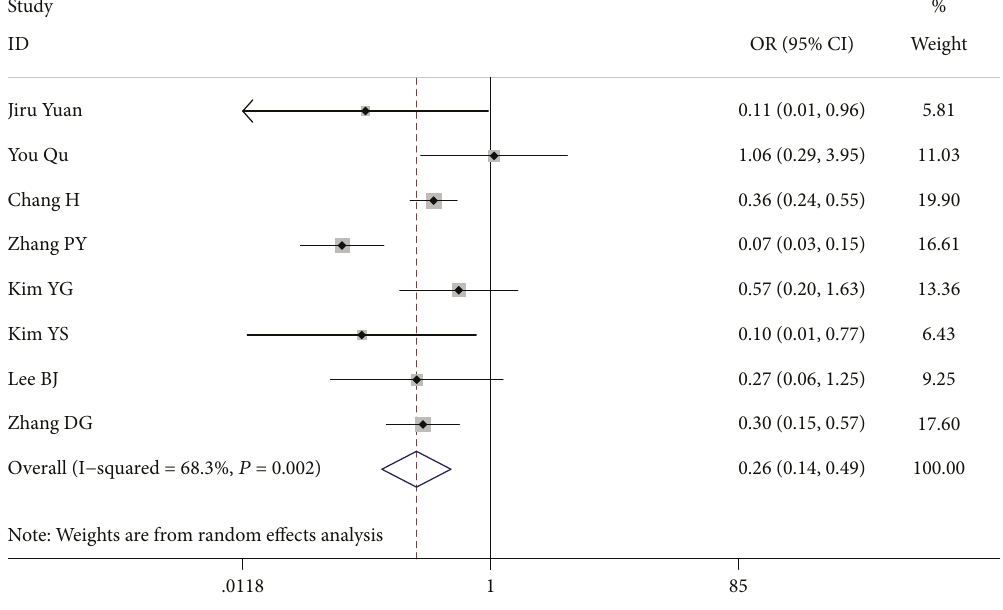
Figure 8: Forest plot for metastasis according to extrathyroidal invasion.